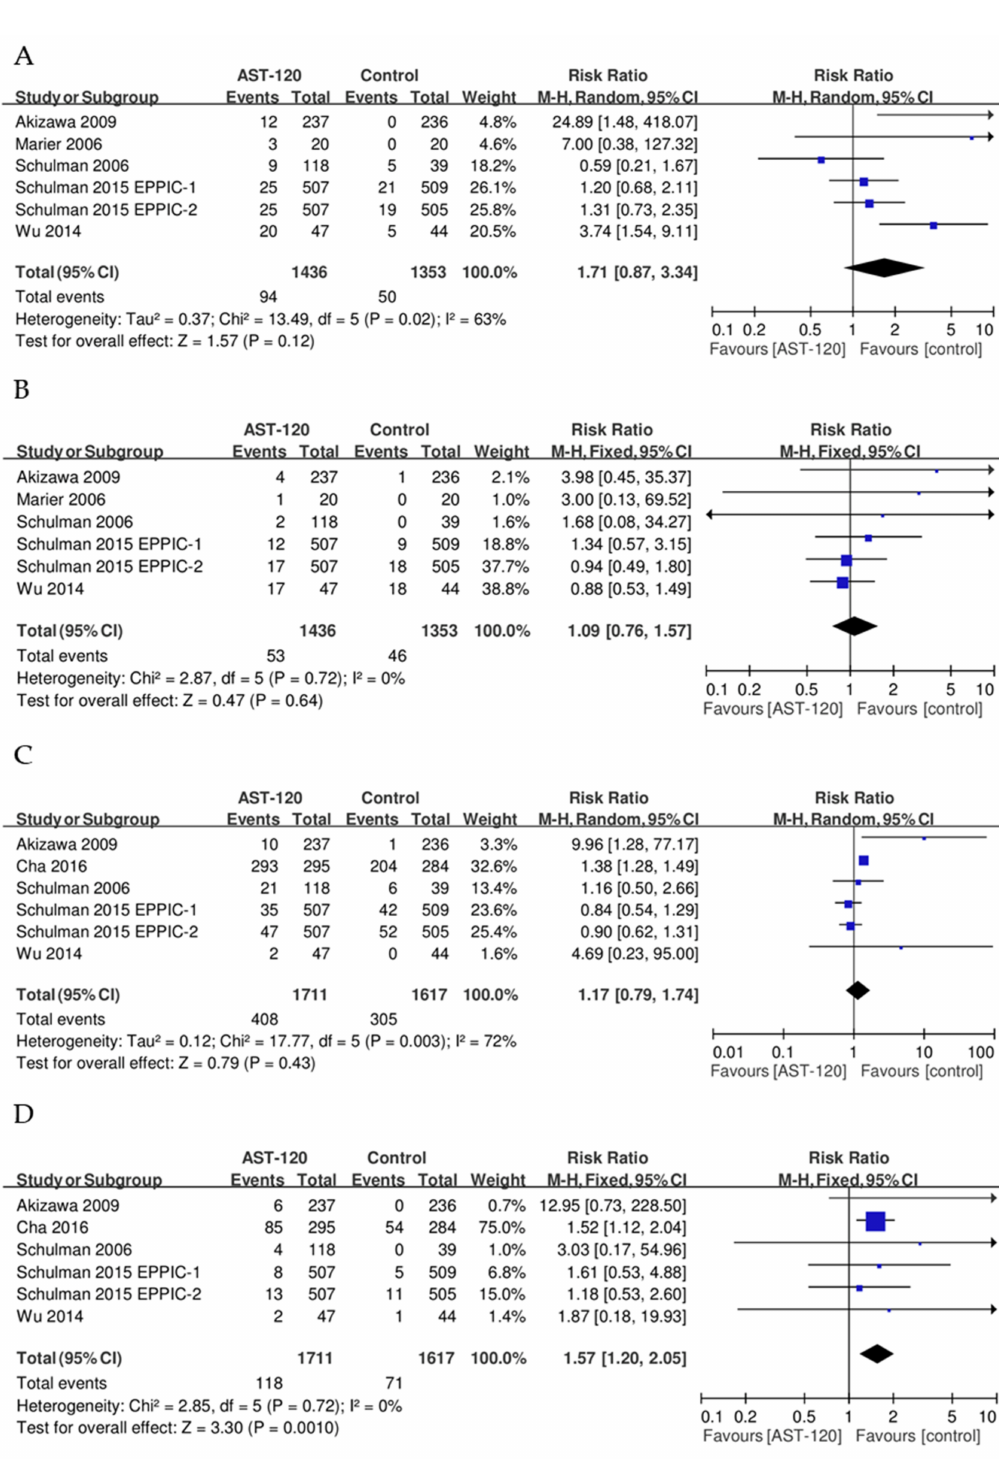
Figure 4. Result of secondary outcomes for comparison between AST-120 and control